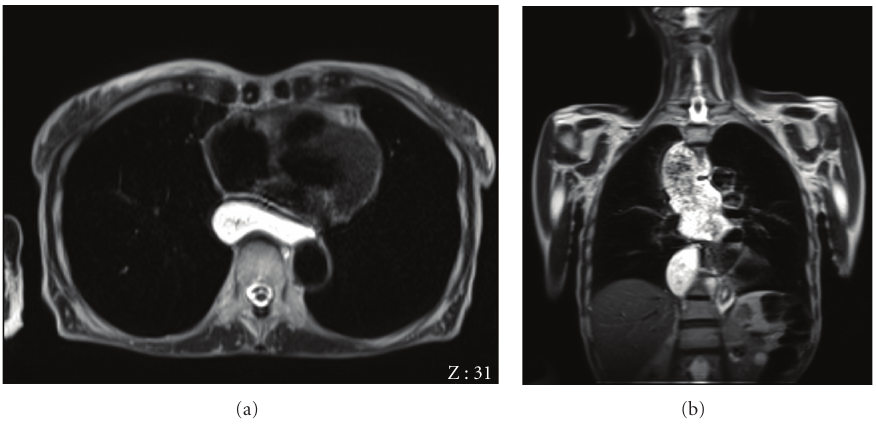
Figure 1: Morphologic axial (a) and coronal (b) T2w sequences demonstrate the significant increases of oesophageal caliber.